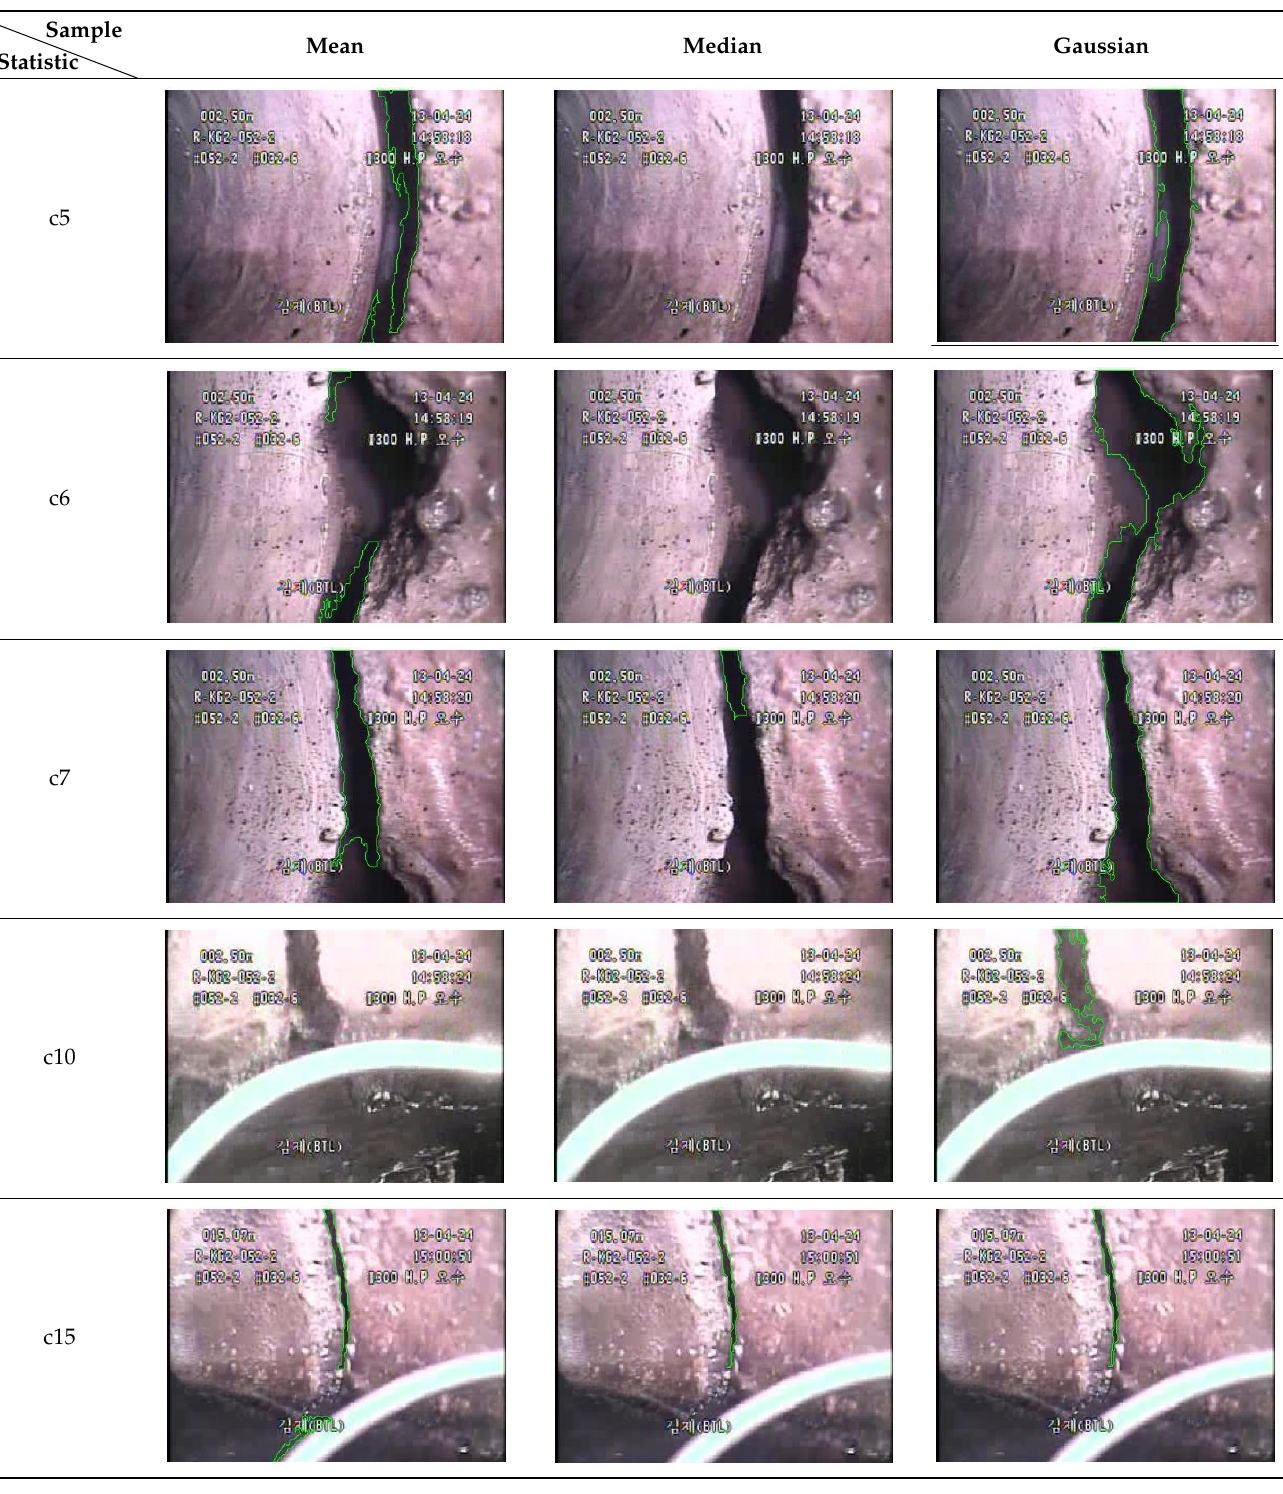
Table 7. Comparison of results by Var. #3.